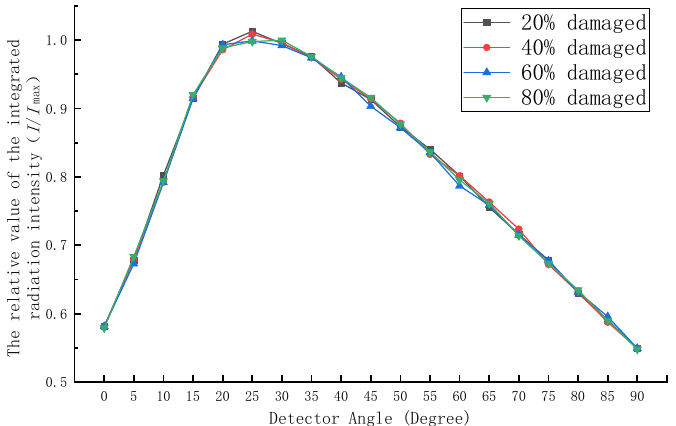
Figure 19. Radiation intensity curves of adjusting plates 1 and 4 with different damage degrees. Second, a comparison was conducted to determine whether the positions of the damaged adjusting plates affect the radiation intensity when two adjusting plates are damaged. The settings of each scheme are as follows. Schemes A, B, C and D entail the damage of adjusting plates 1 and 3, 1 and 5, 1 and 7, and 1 and 8, respectively, considering a damage degree of 80%. The calculation results reveal that, considering the same number of damaged adjusting plates and the same damage percentage, the variation trend of the infrared radiation intensity is not closely related to the position of the adjusting plate if the two damaged external adjusting plates are on the same side. The infrared radiation intensity curve is presented in Figure 20.